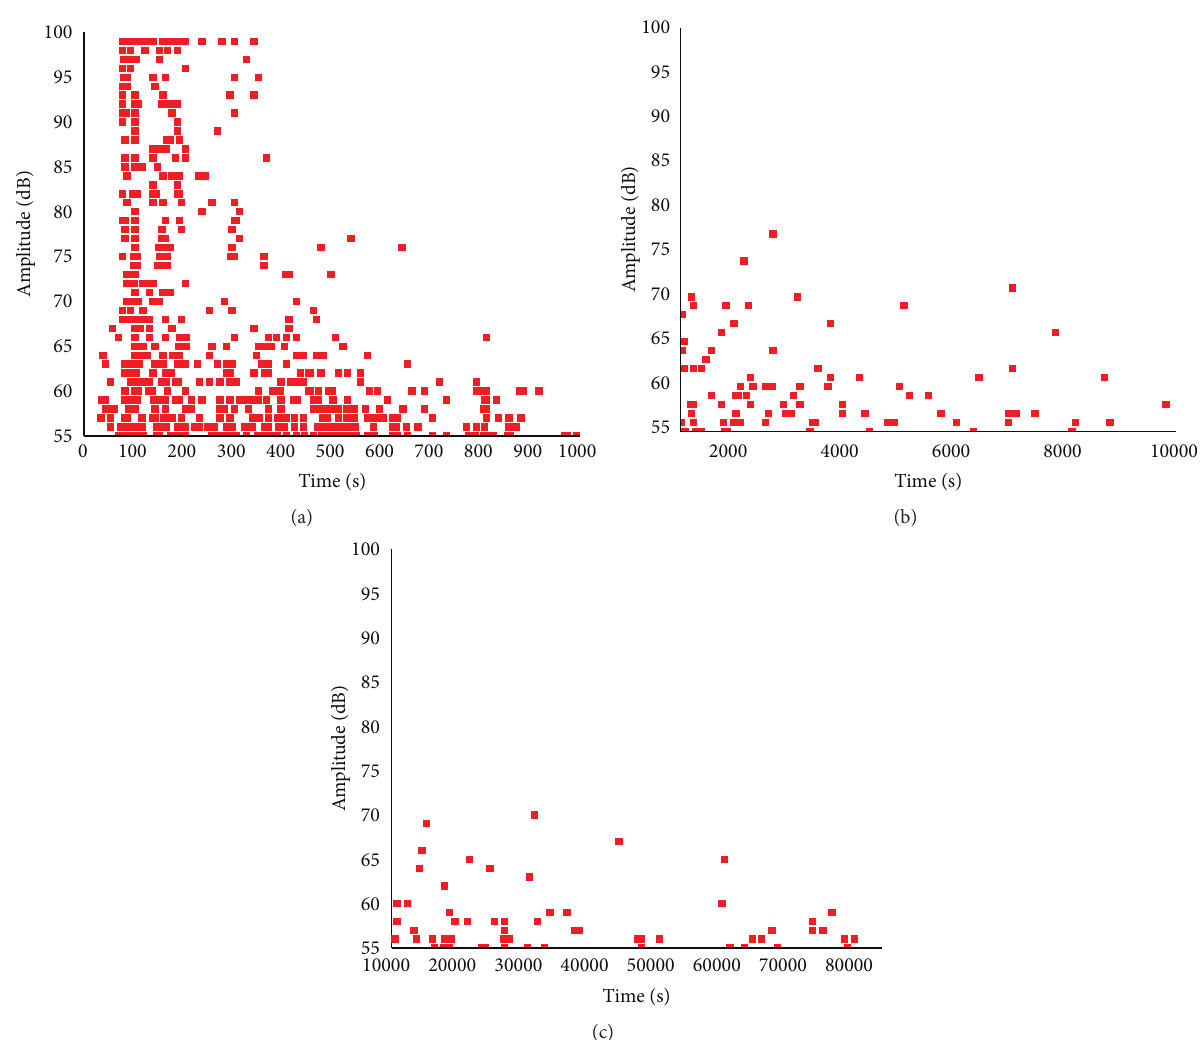
Figure 4: Change of AE hit amplitude with the tensile loading time: (a) 0s–1000s; (b) 1000 s–10000s; (c) 10000s–80000 s.